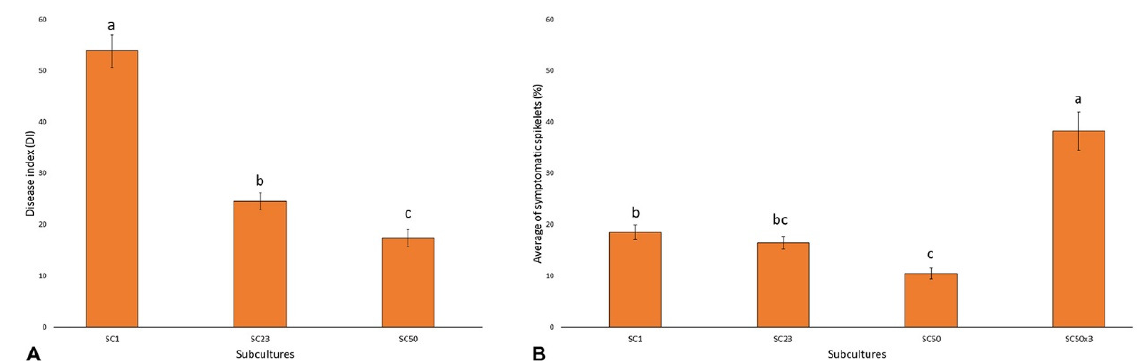
Figure 2. ( A ) Stem base Disease Index (DI) of soft wheat inoculated with subcultures SC1, SC23, and SC50 of F. graminearum strain FG8. Columns represent the average of three replicates ( ± SE) with each composed of 10 plants. Values with different letters are significantly different based on Duncan’s multiple comparison tests ( p < 0.05). ( B ) Average percentage of symptomatic spikelets (%) of heads point-inoculated with the FG8 different subcultures. Columns represent the average of three replicates ( ± SE), in which each is composed of five heads. Values with different letters are significantly different based on Duncan’s multiple comparison tests ( p < 0.05).